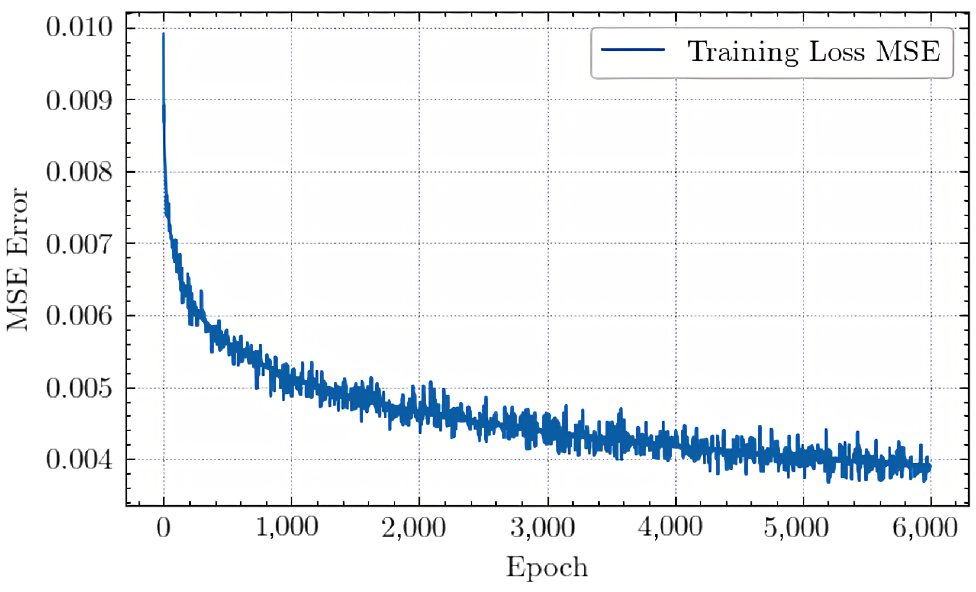
Figure 4. M-SRPCNN Training MSE loss.